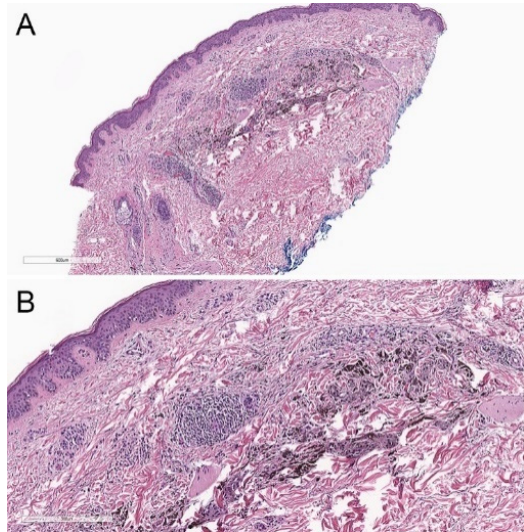
Figure 3. Deep penetrating nevus associated with a predominantly intradermal melanocytic nevus as part of a combined nevus. ( A ), Hematoxylin and eosin, 40×. ( B ) Hematoxylin and eosin, 100×. as part of a combined nevus. ( A ), Hematoxylin and eosin, 40 × . ( B ) Hematoxylin and eosin, 100 ×